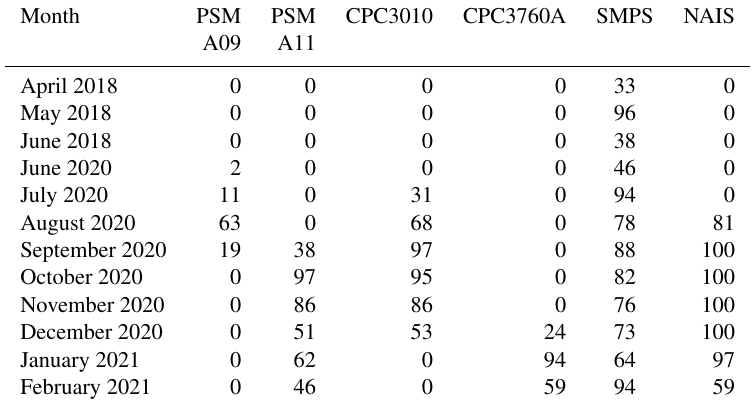
Table A1. Percentage of data available for each instrument each month calculated based on 30min averaged data. Month